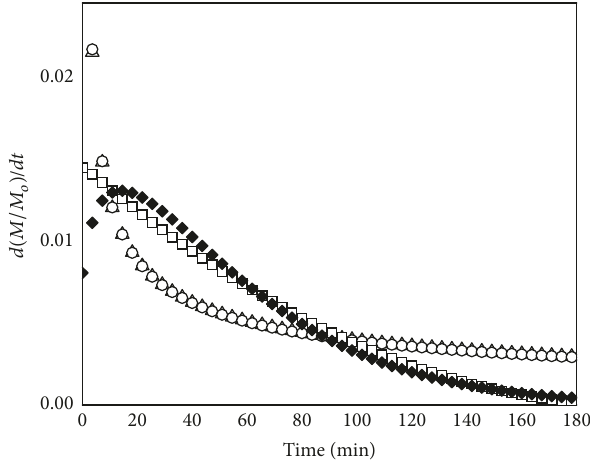
Figure 8: Release rate for sample F1/5/1: models of ( △ ) Higuchi, ( I ) Korsmeyer-Peppas, ( ◻ ) Hixson, and ( X ) Weibull.